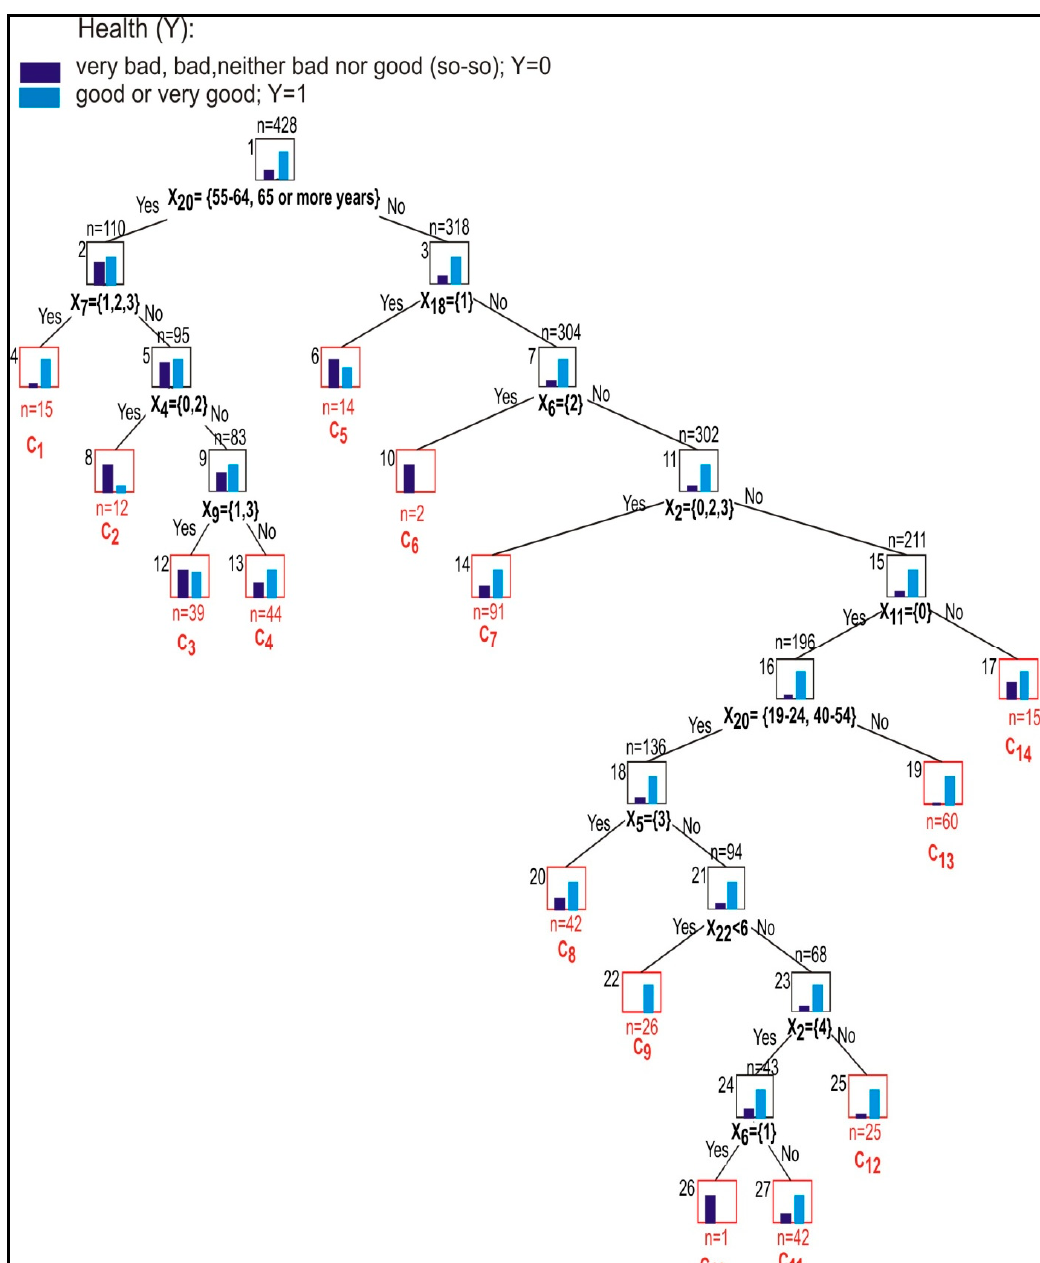
Figure 1. Classification tree for health assessment.